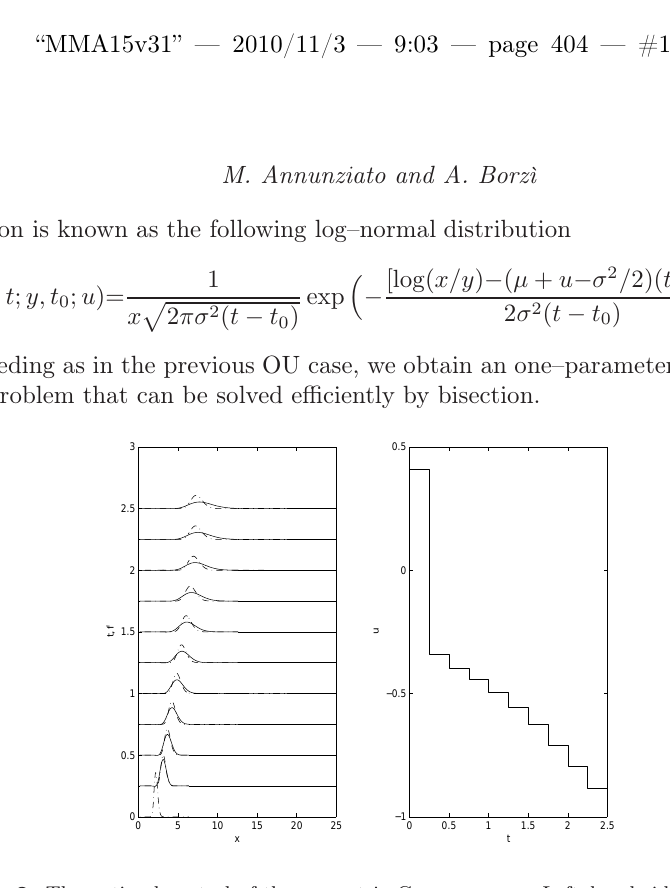
Figure 2. The optimal control of the geometric Gauss process. Left–hand side: computed PDF (solid line) and desired PDF (dotted-dashed line) at different time windows. Right–hand side: The optimal control